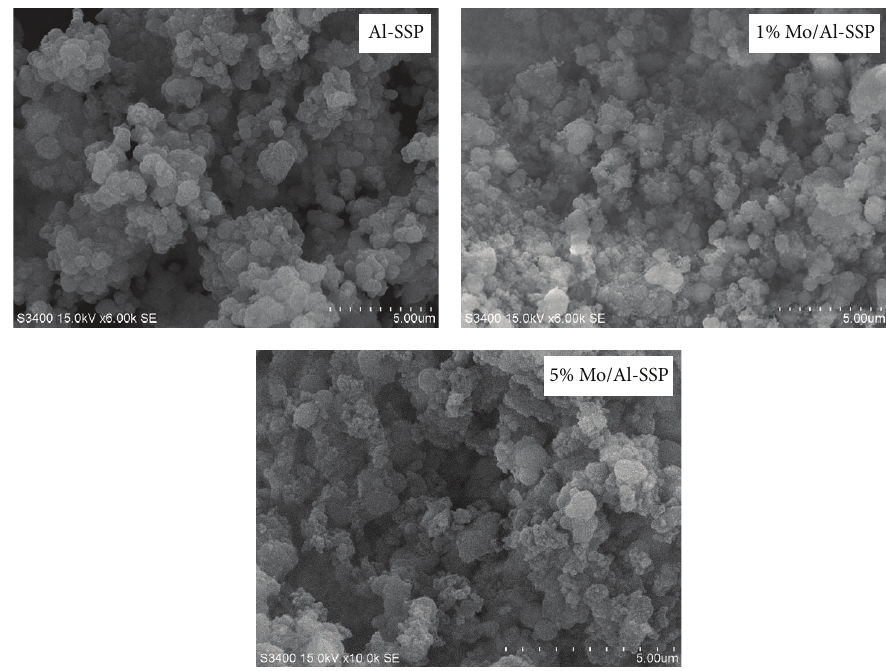
Figure 4: The SEM micrographs of all catalysts.